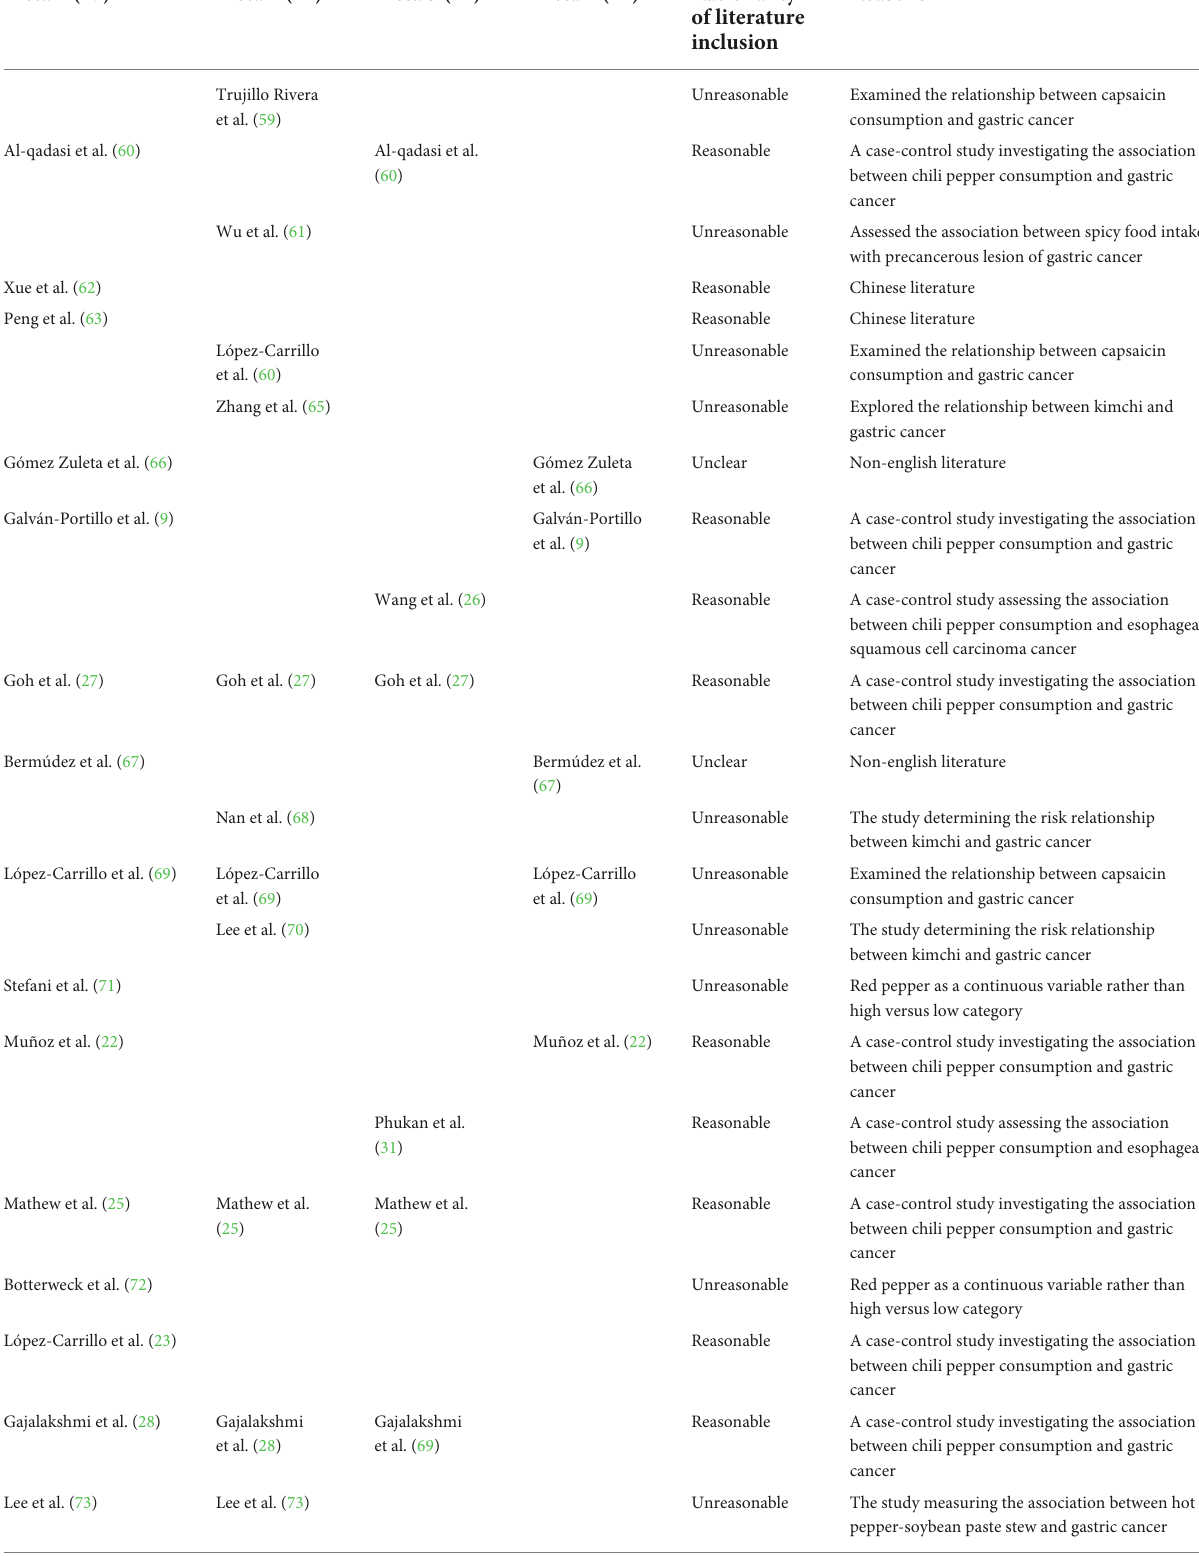
TABLE 3 Eligibility survey of the original included literature on the relationship between chili pepper consumption and GI